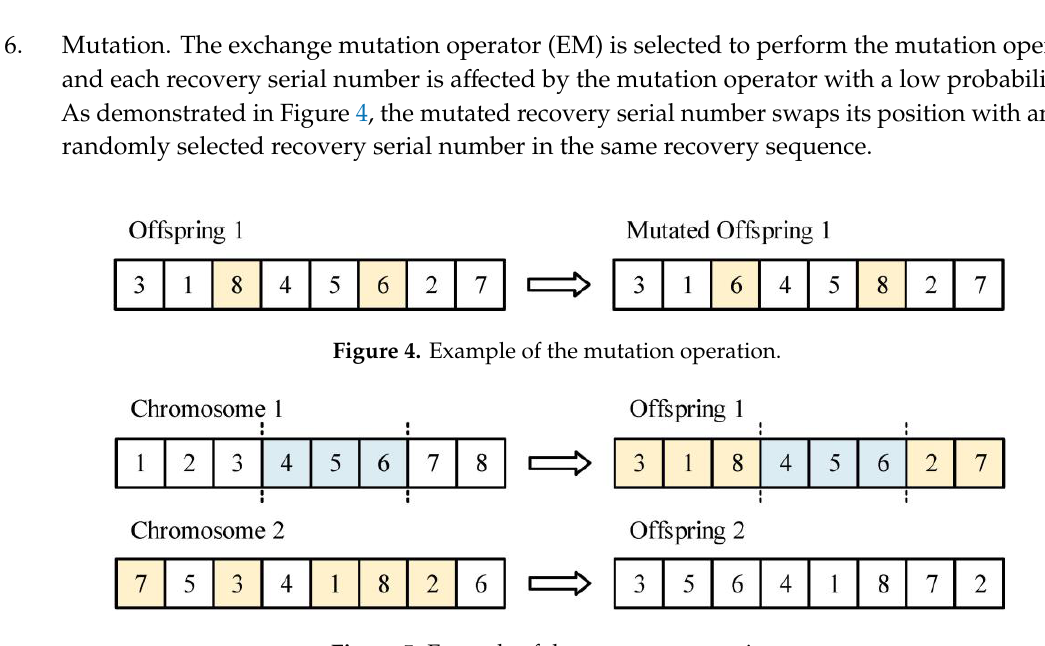
Figure 5. Example of the crossover Figure 4. Example of the crossover operation.